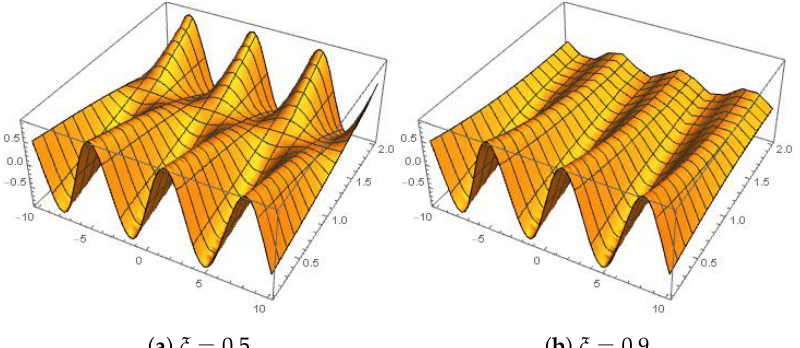
Figure 1. Approximate solutions for ξ = 0.5 and ξ = 0.9.